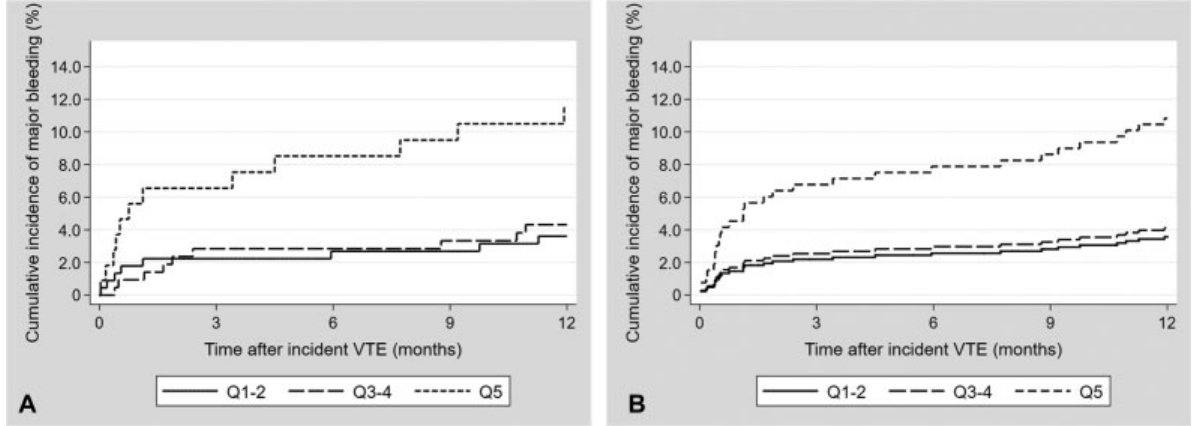
Fig. 1 One year cumulative incidence of major bleeding by categories of D-dimer estimated by 1-Kaplan – Meier ( A ) and in the presence of death as competing event ( B